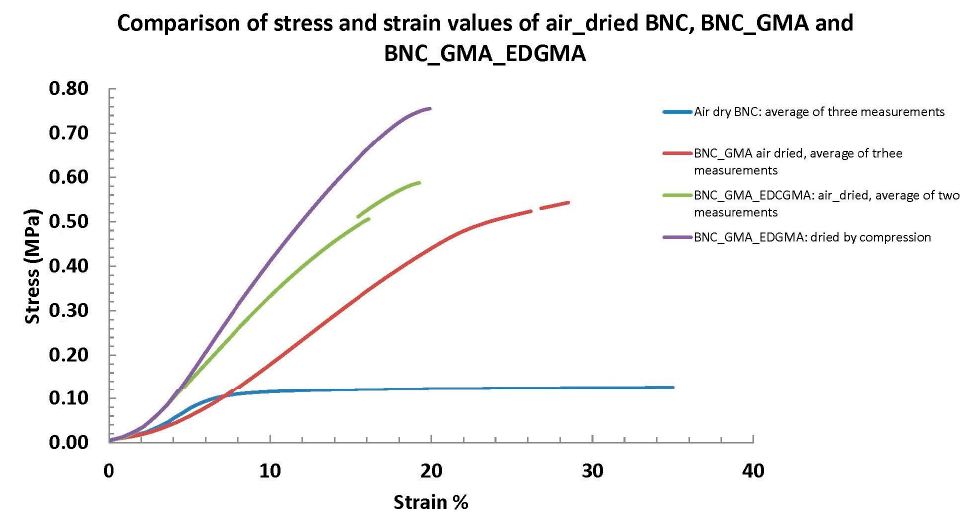
Figure 16. BNC (blue); BNC-GMA 0.64 MS (brown); BNC-GMA-EGDMA 0.7–1 MS (green and violet) stress and strain.